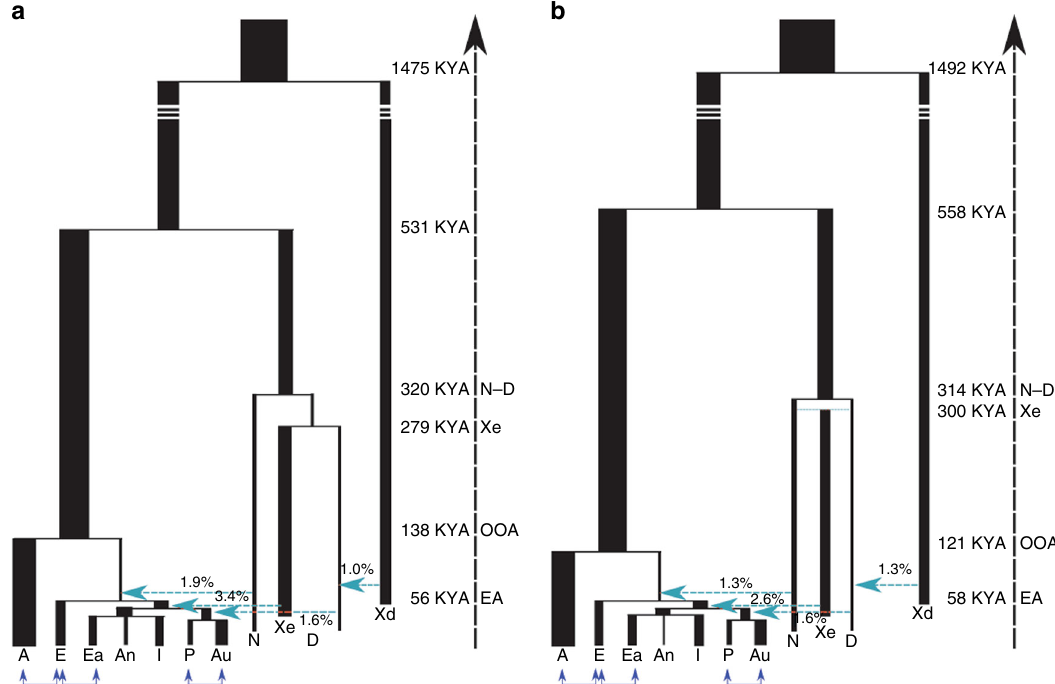
Fig. 3 Graphical representation of the two best supported model (Model F and Model H) with mean posterior distribution of each parameter. a Mean of the posterior distributions of each parameter calculated by means of ABC-DL in model F for Africans (A), Europeans (E), East Asians (Ea), Andamanese (An), Indians (I), Papuans (P), Aboriginal Australians (Au), Altai Neanderthal (N) and Denisovan (D). The model includes an extinct hominin population (Xe) descendent from the Denisovan population. b Mean of the posterior distributions of each parameter calculated by means of ABC-DL in model H. Xe population is an admixture between Neanderthals and Denisovans which interbreeds with Asian populations and a Homo erectus -like population (Xd) that interbreeds with Denisovan. In blue, some of the recent continuous migrations between populations which were taken into consideration in the model. In turquoise, the different introgressions